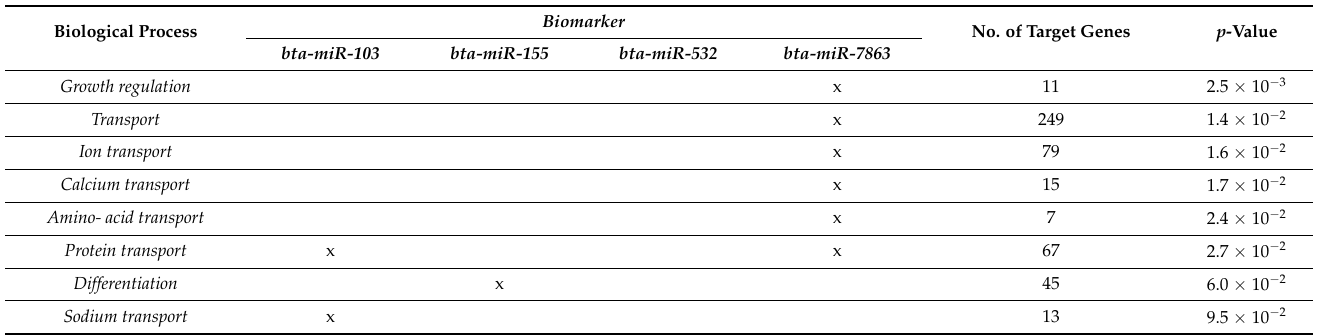
Table 2. Biological processes that are associated with milk production and metabolism and that are predicted to be regulated by milk miRNAs with differential levels across production